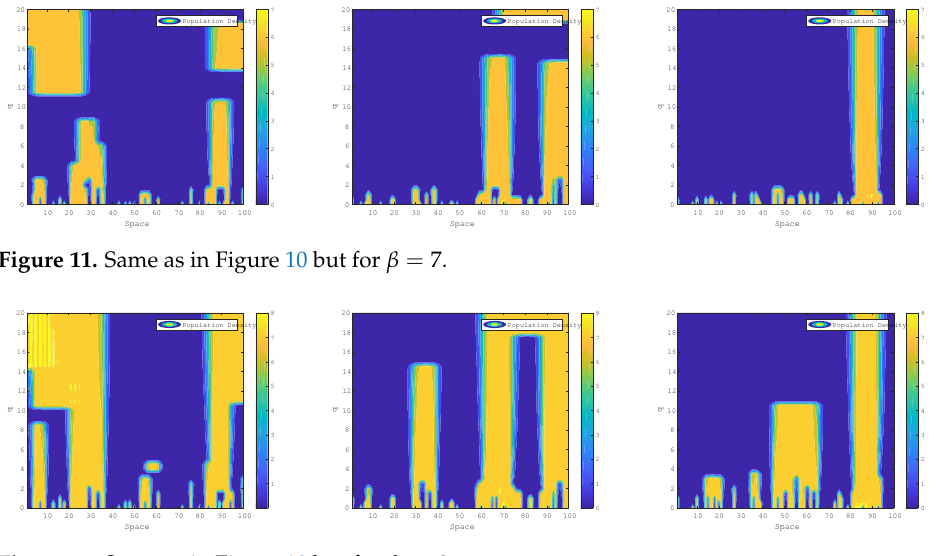
Figure 12. Same as in Figure 10 but for β i =